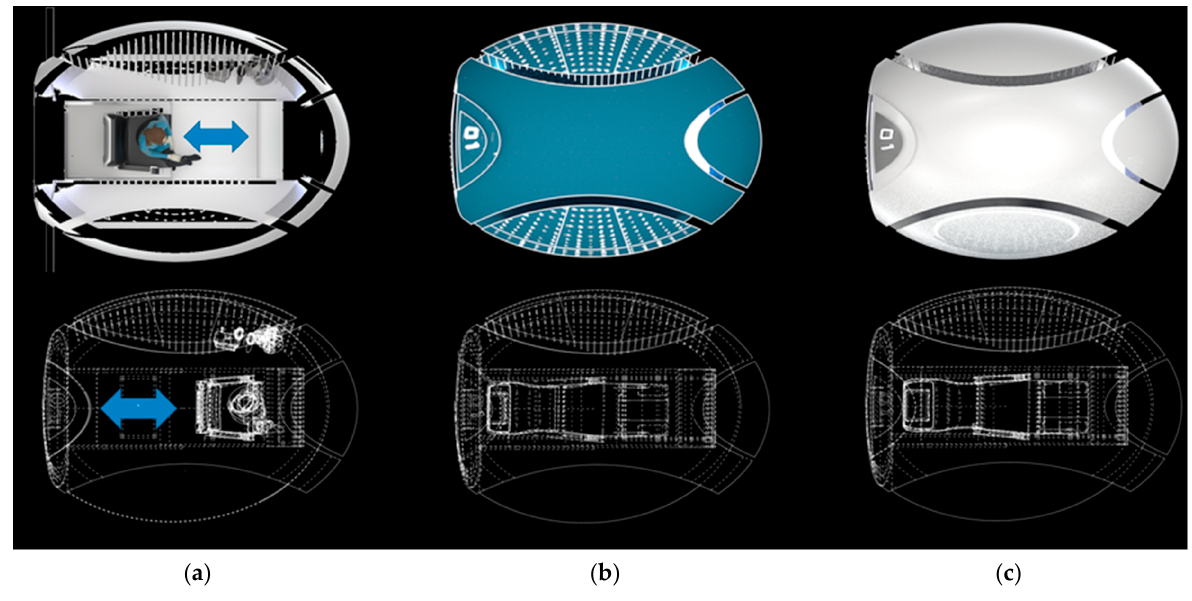
Figure 11. Different rendered and technical views of the “Reviving Pod“: ( a ) working/meeting position and plan, ( b ) relaxation/meditation position and plan, and ( c ) napping position (designed by the authors).